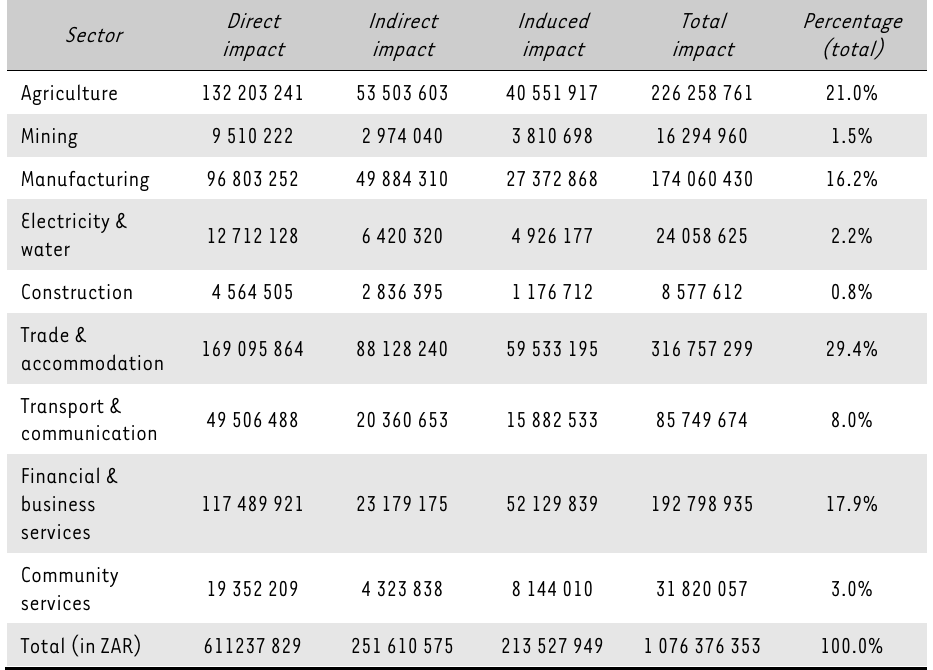
Biltong hunters’ impact through production multipliers (ZAR, 2006